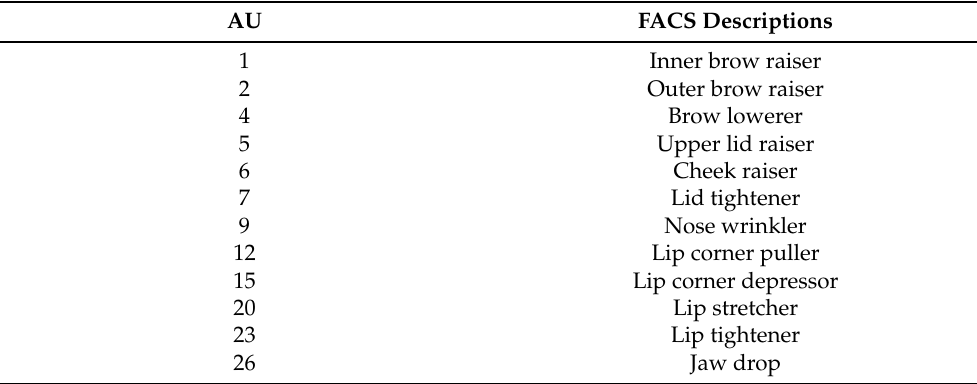
Table 1. List of the most used action units and their respective FACS